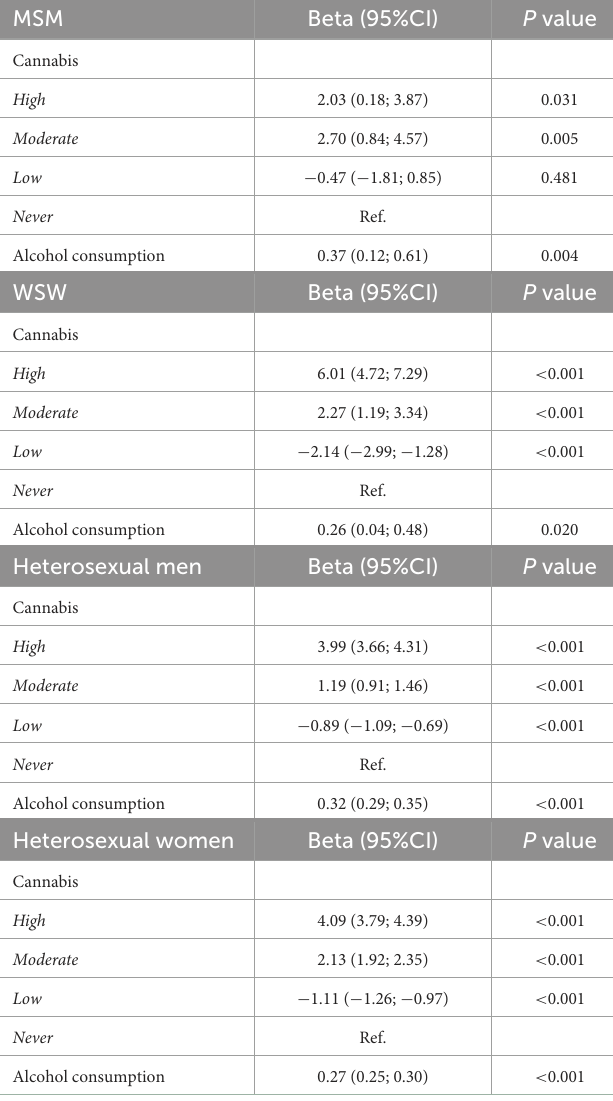
TABLE 2 Multivariate linear regression models for cannabis use and alcohol consumption with lifetime number of sexual partners, with adjustment for age, BMI, lifetime sexual activity, education, income, smoking pack years and CV